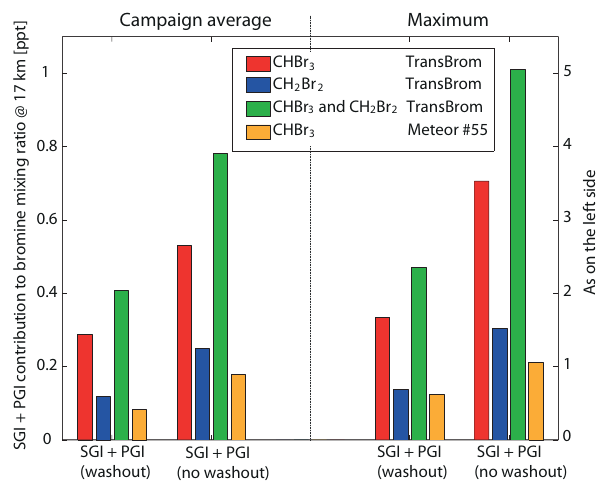
SGI + PGI (washout) (no washout) Fig. 6. Modeled stratospheric Br mixing ratios (ppt) at 17kmfrom SGI and PGI contributions based on West Pacific (TransBrom) CHBr 3 , CH 2 Br 2 and tropical Atlantic (Meteor#55) CHBr 3 emis- sions. Results are given in form of the campaign average values (left side) and in form of maximum values found for peak emission events (right side), taking washout and no wash-out simulations into account (see also Fig.